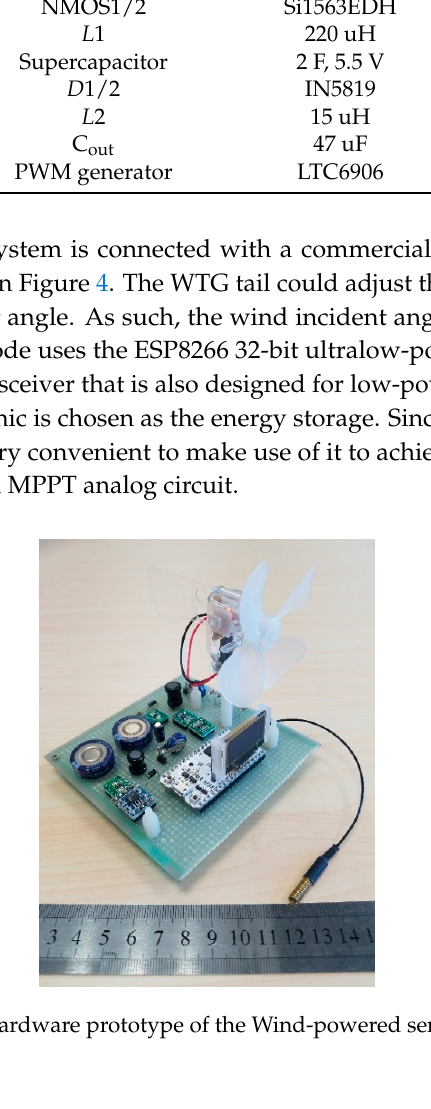
Table 1. Catalog of hardware components.